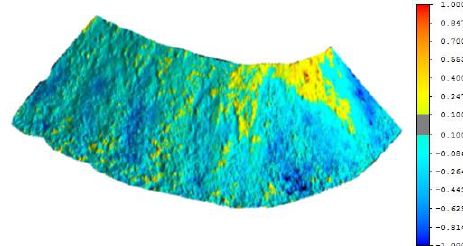
Fig.7 Discrepancy map of 3D distances based on